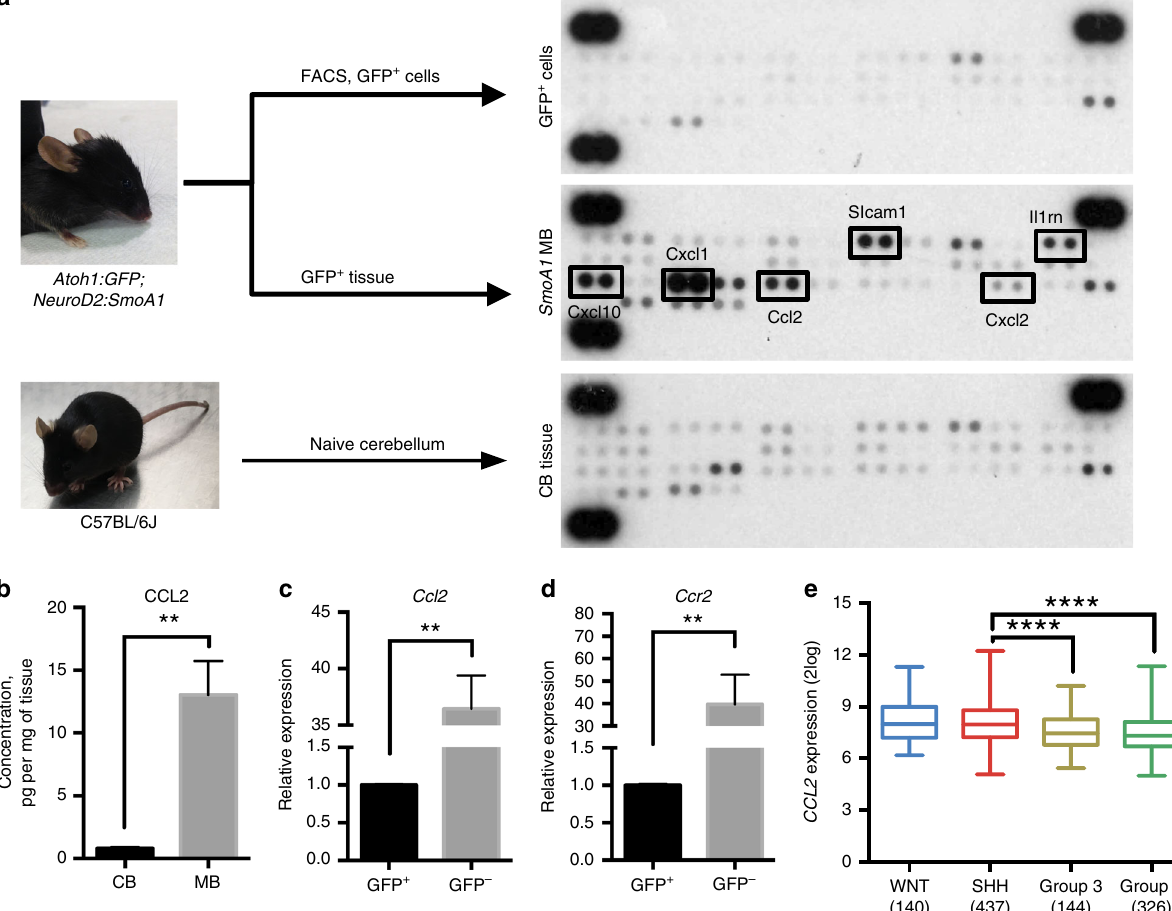
Fig. 3 CCL2 is a key monocyte chemo-attractant cytokine in SHH MB. a Schematic of the experiment and results of cytokine analysis. NeuroD2:SmoA1 ; Atoh1:GFP tumour GFP tissue was extracted under a fl uorescence microscope and either dissociated and FACS-sorted to isolate GFP + cells or homogenised ( SmoA1 MB); naive cerebellum was used as a control (CB tissue). Images are representative of three independent experiments. b ELISA analysis of CCL2 cytokine level in cerebellum (CB) and medulloblastoma (MB) tissue, N = 9, Mann – Whitney U test, ** P < 0.01. c , d Relative Ccl2 ( c ) and Ccr2 ( d ) expression levels in FACS-sorted cells, GFP + are tumour cells, GFP − are cells of the tumour microenvironment. N = 6, Mann – Whitney U test, ** P < 0.01. e Microarray data analysis of human patient cohort for CCL2 gene 13 . WNT Wingless, SHH Sonic Hedgehog, N = 140 for WNT, N = 437 for SHH, N = 144 for group 3, and N = 326 for group 4. Box plots represent median and quratiles with whiskers indicating range of values. One-way ANOVA with multiple comparisons, F = 19.17, **** P < 0.0001. Data are represented as mean ± S.E.M. for b –